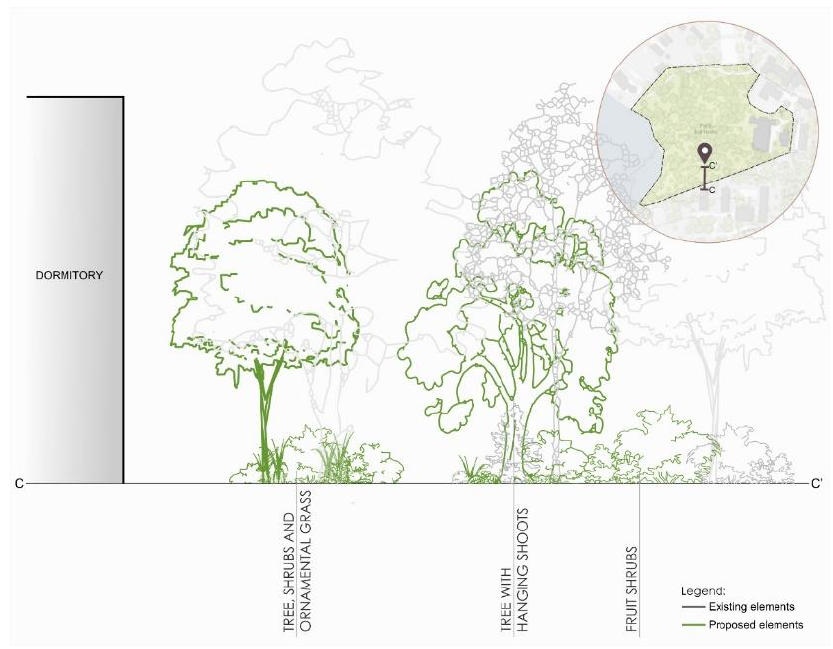
Figure 11. Scheme for re-design of the C zone in Kortowo park.